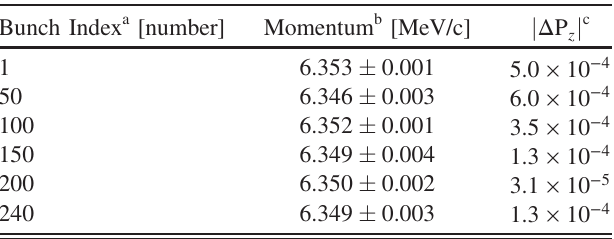
TABLE I. Measured bunch momentum along a 240 μ s